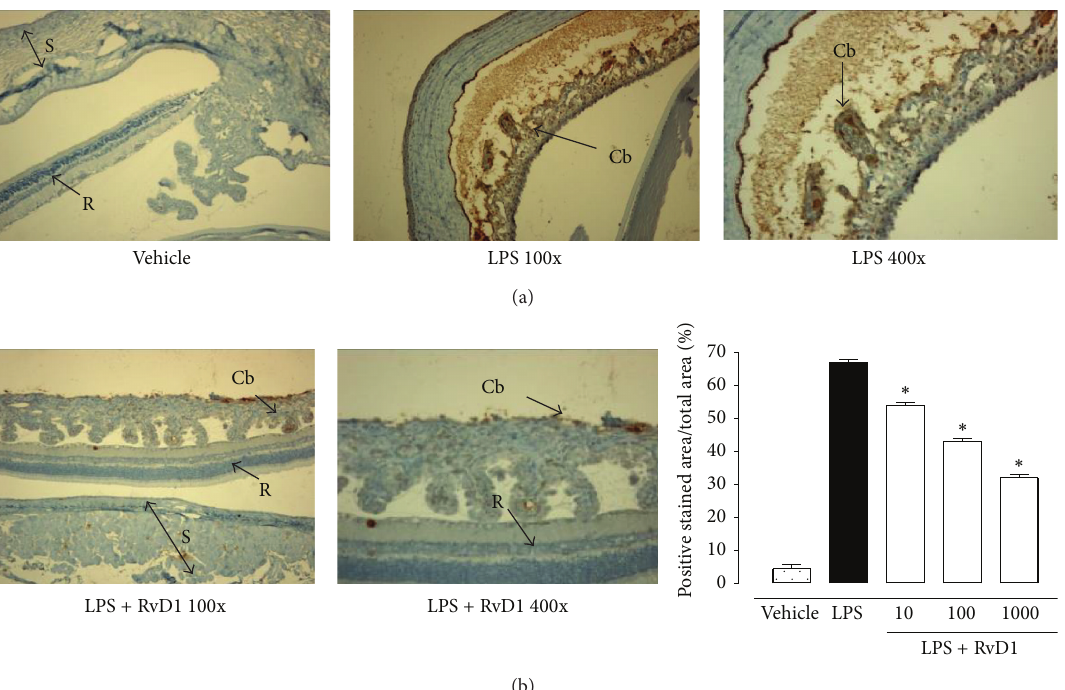
Figure 3: Intravitreal Resolvin D1 (RvD1) reduced CD20 + immunostaining. (a) Representative immunohistochemistry showing that intravitreal RvD1 decreased immunostaining for CD20 + B cell, already significant at the lowest dose (10ng/kg, 1h post-LPS treatment) with respect to the LPS treated rats. (b) Graph showing the percentage of the total positive stained area for CD20 + per total area analyzed at 400x magnification. Values are mean ± SEM of 𝑛 = 6 observation for each group. ∗ 𝑃 < 0.05 and ∗∗ 𝑃 < 0.01 versus LPS-treated group. R = retina; S =